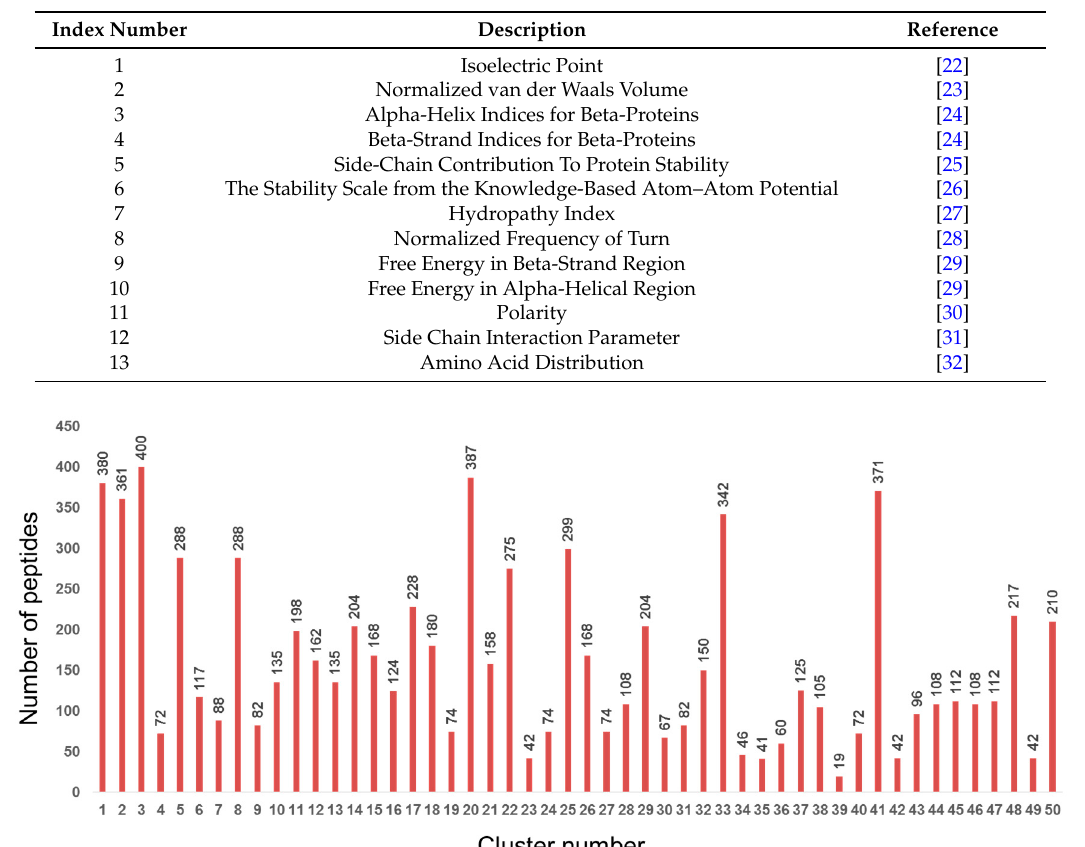
Table 1. The 13 amino acid indices (selected from a total of 531 indices) used for characterization of tripeptides.